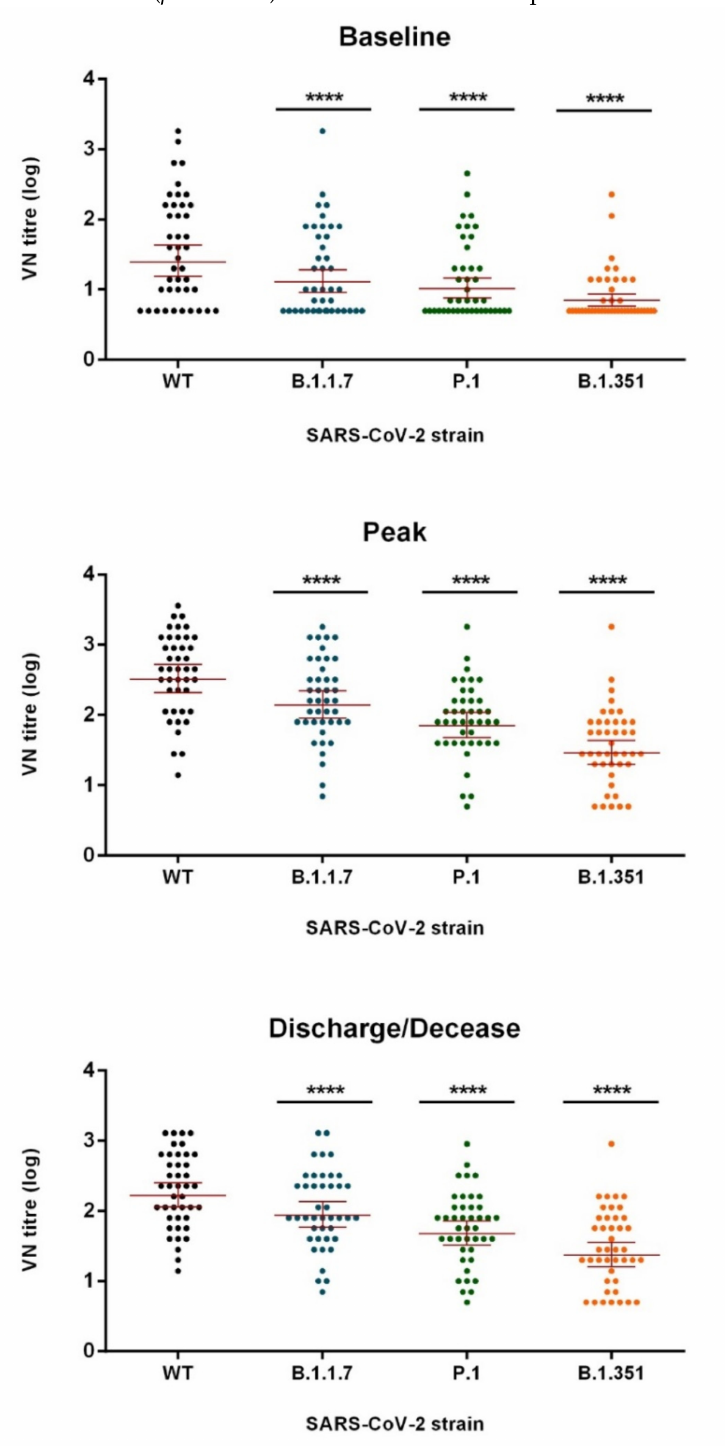
Figure 1. SARS-CoV-2 virus-neutralization (VN) titers with geometric mean and 95% confidence intervals, by time point and strain. For each variant, VN titers were compared with respect to the wt strain using a paired t -test (**** p ≤